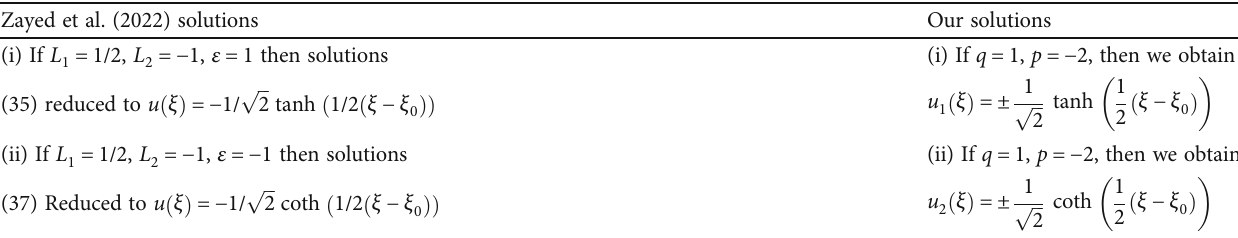
Table 1: Comparison between Zayed et al. ([26]) solutions and our solutions. Zayed et al. (2022) solutions Our